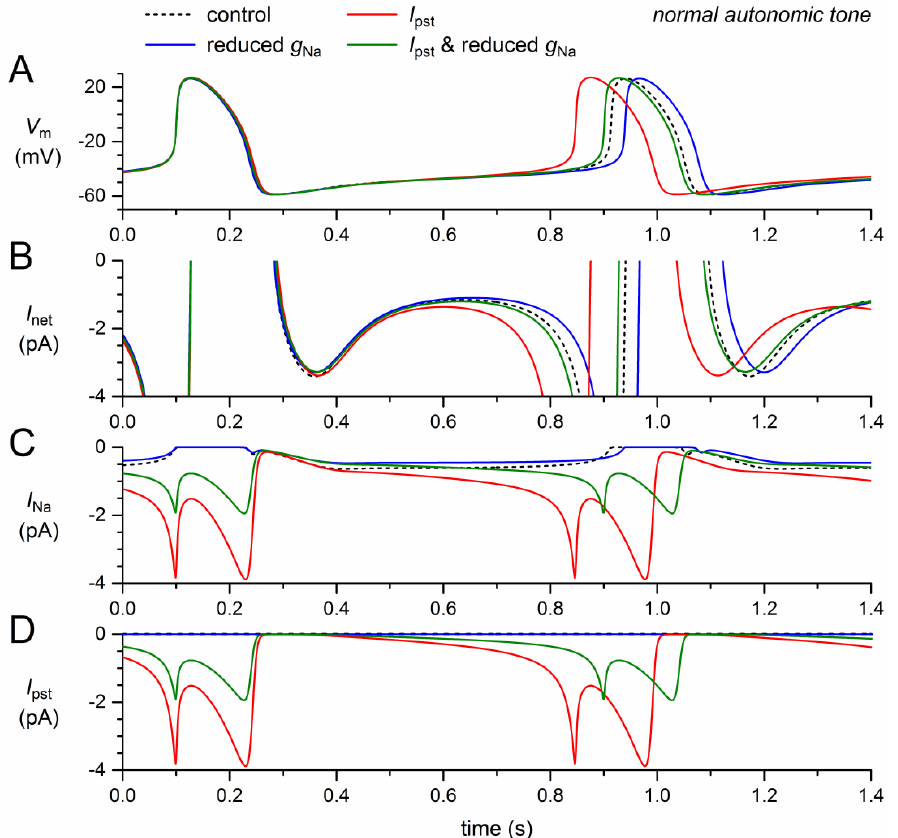
Figure 3. Effect of a 50% decrease in fully-activated conductance ( g Na ) and a 1.0 – 1.5% persistent current ( I pst ) as observed for the 1795insD mutation in SCN5A on the electrical activity of the Fabbri–Severi model cell at normal beating rate (normal autonomic tone). ( A ) Membrane potential ( V m ). ( B ) Net membrane current ( I net ). ( C ) Fast sodium current ( I Na ). ( D ) Persistent component of the fast sodium current ( I pst ). Effect of the reduced g Na per se (blue traces), the persistent I Na per se (red traces), and the combined effect (green traces). In the model, I Na is split into a wild-type and a mutant component, thus representing the effect of a heterozygous mutation.